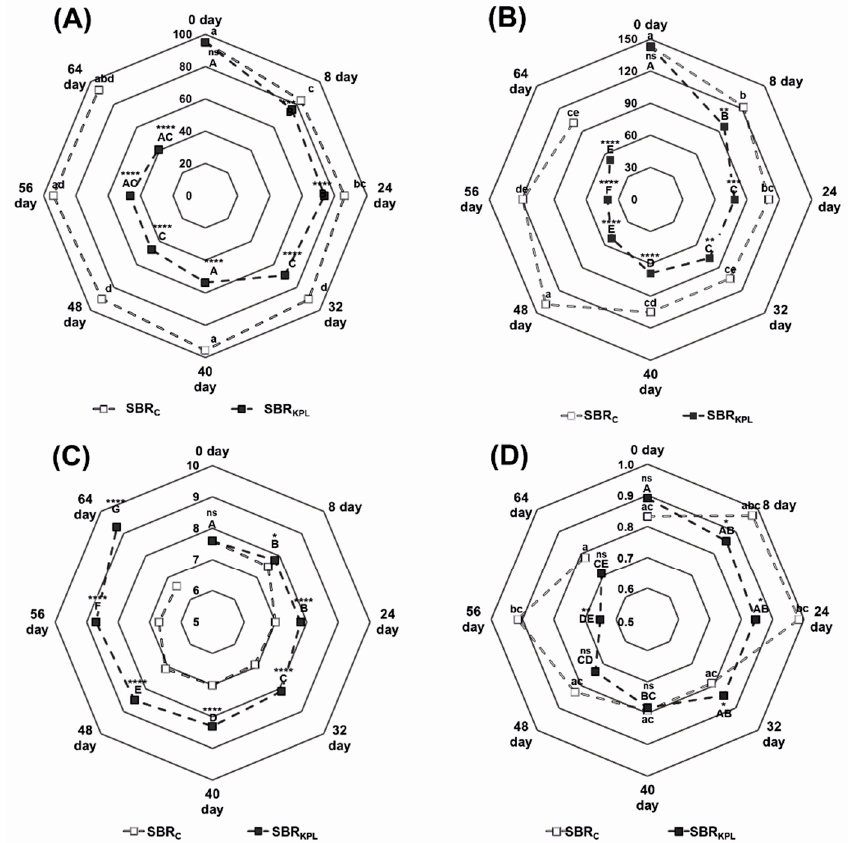
Figure 3. The changes in removal efficiency of chemical oxygen demand (CODr) ( A ), sludge volume index (SVI) ( B ), pH value ( C ), and the ratio of MLVSS/MLSS ( D ) in the SBR C and SBR KPL during 64 days of wastewater treatment.